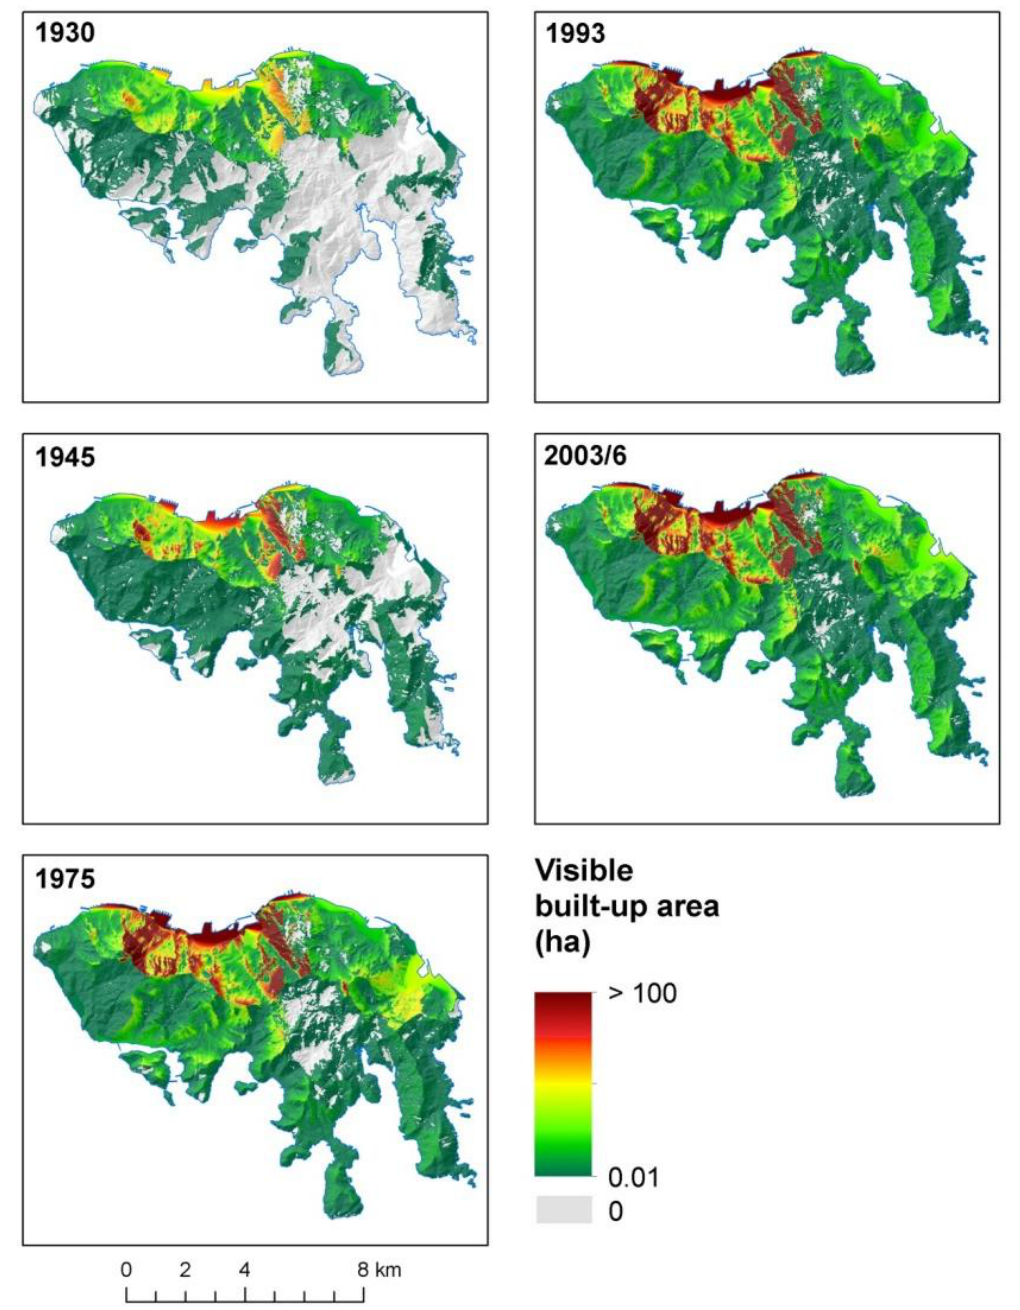
Figure 7. Changes in the visibility of built-up areas between 1930 and 2003/6. Values represent the amount of built-up areas visible from each 10 × 10 m grid cell (100 m 2 ). In this analysis information about the height of individual buildings was not incorporated. Grey areas indicate areas from which no buildings were